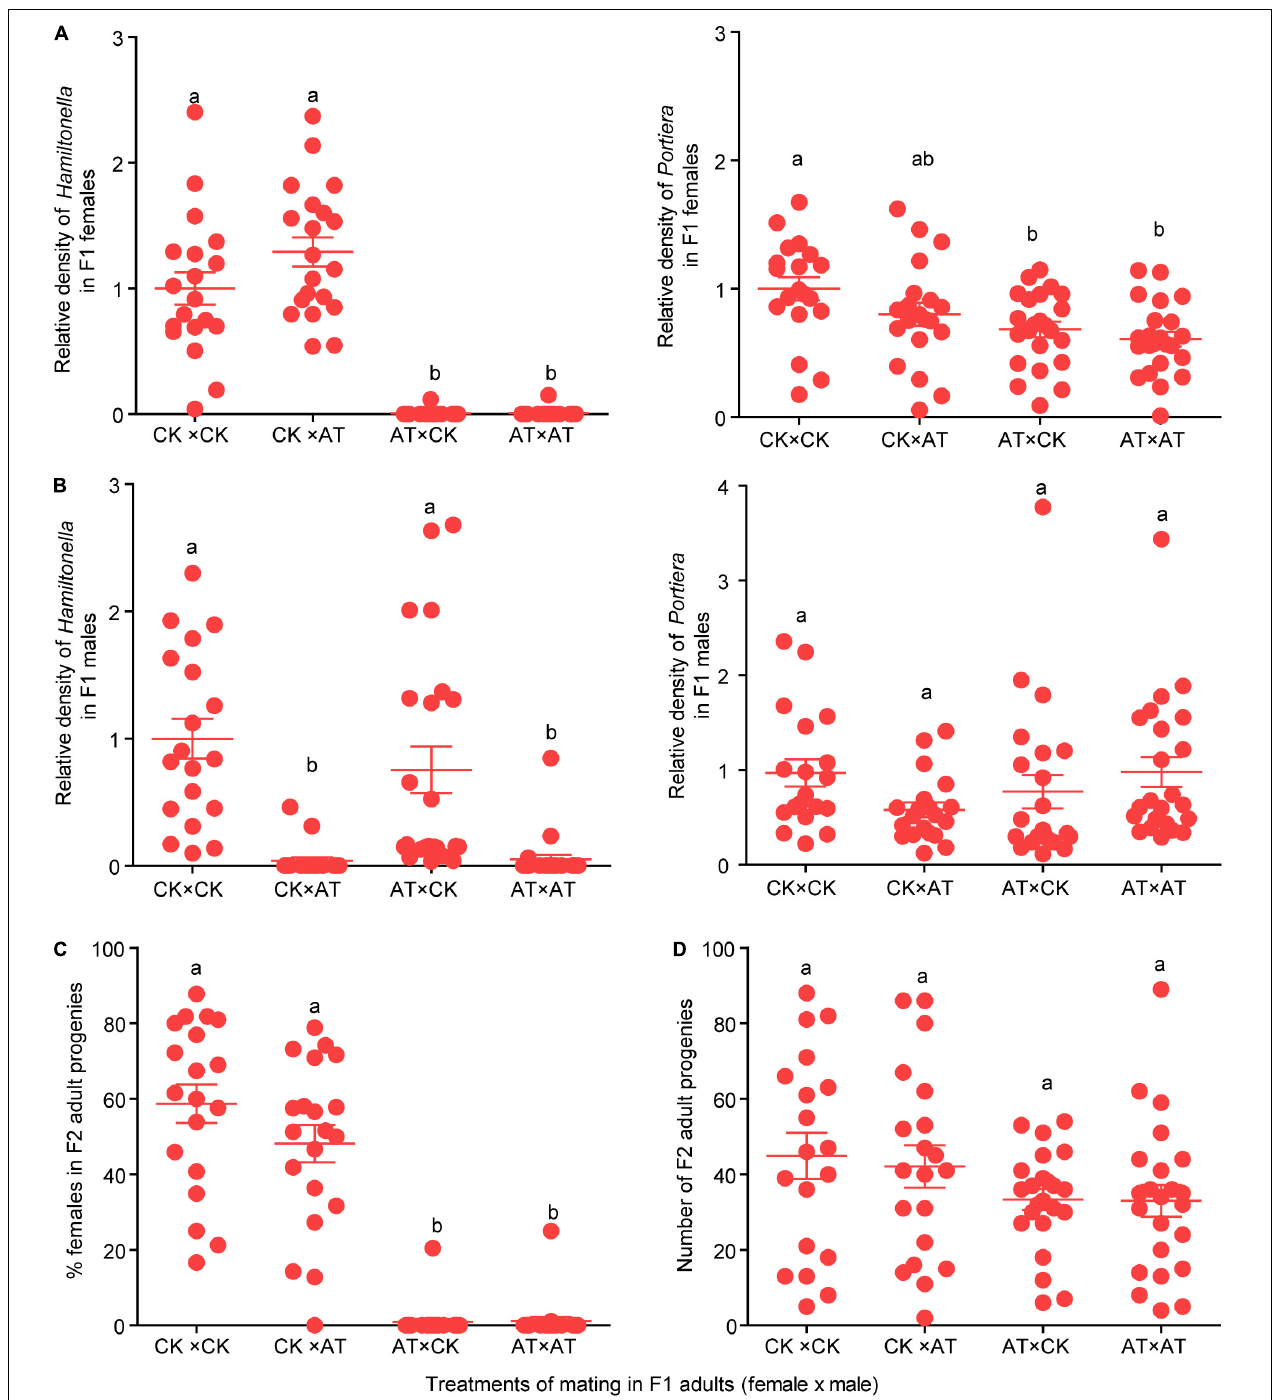
FIGURE 4 | Effects of Hamiltonella on sex ratio and number of progenies. (A,B) Relative density of Portiera and Hamiltonella in F1 female (A) and male (B) adults used in the four crosses between CK (control) and AT (Antibiotics treatments). The relative density of the symbionts was measured as the ratio of bacterium single-copy 16S rRNA genes to insect single-copy β -actin genes. (C,D) Percentage of female progenies (C) and number of adult progenies (D) of F2 produced by F1 adults in the four treatments of mating between CK and AT whiteflies. CK: Control; AT: F1 adult whiteflies produced by F0 adults that were fed with antibiotics for 4 days. The data are mean ± SEM, and the different letters indicate significant differences at P < 0.05 (One-way ANOVA followed by LSD test for multiple comparisons).